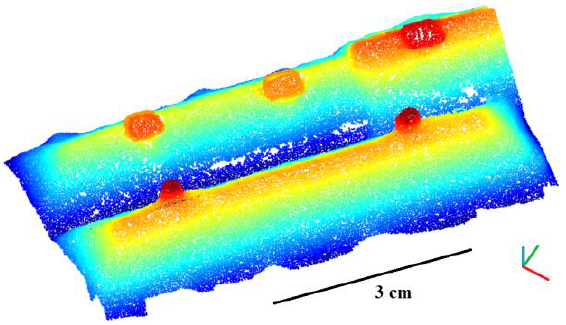
Figure 6. Decomposition of roof point cloud into layers – block